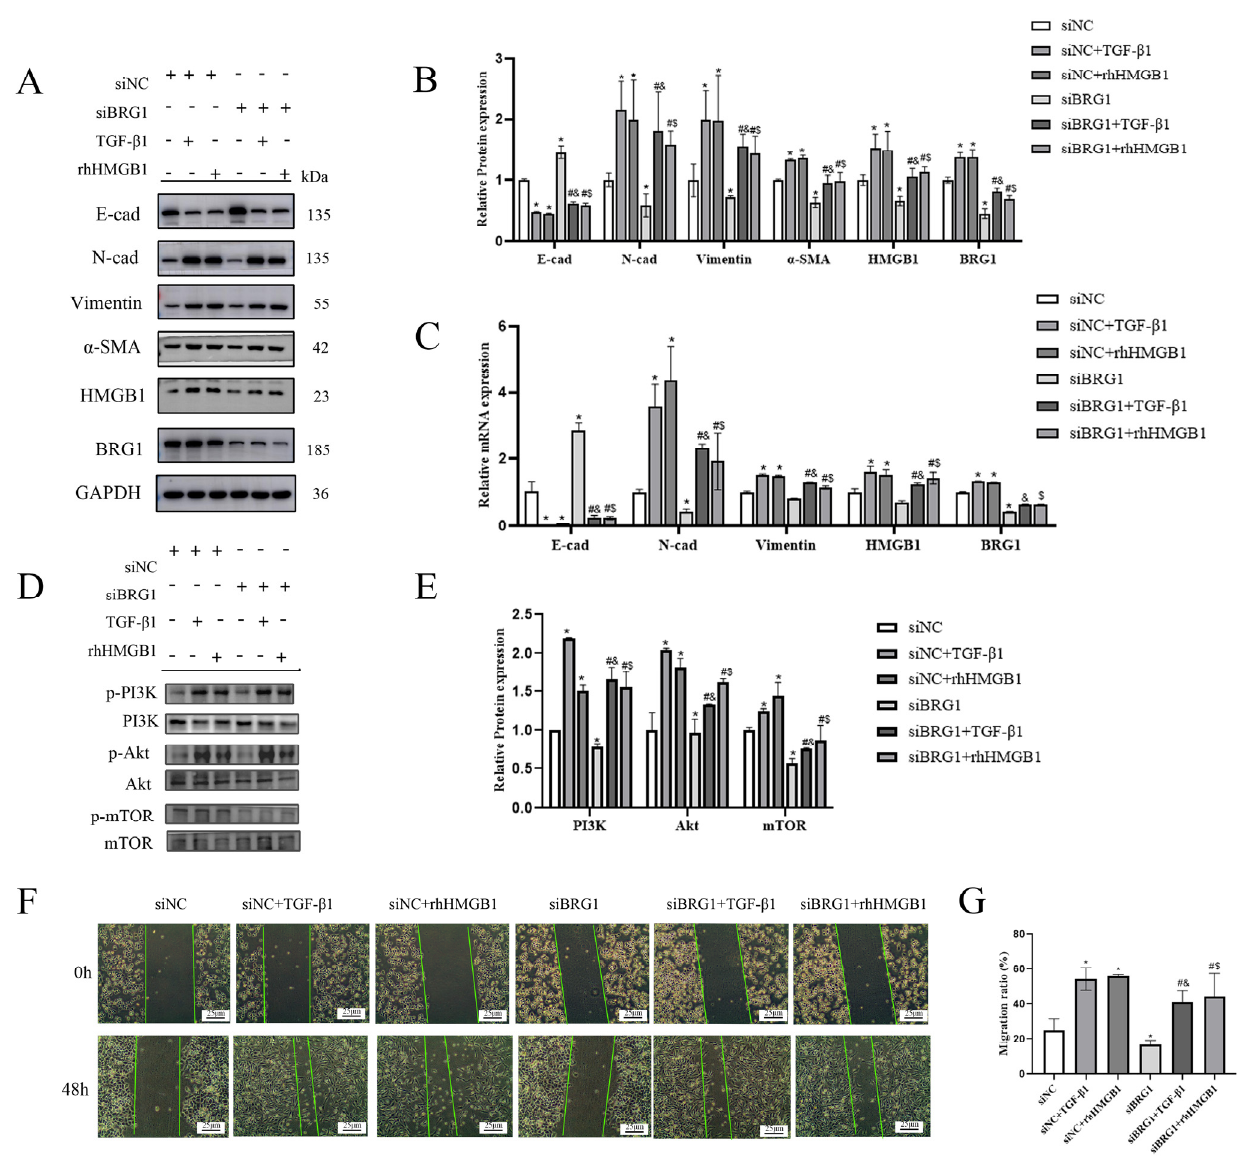
Figure 4. Knocking down BRG1 can slow down the EMT process through PI3K/Akt/mTOR pathway. ( A , C ) After silencing BRG1, cultured in normal medium or medium containing 5 ng/mL TGF- β 1 or 4 ng/mL rhHMGB1 for 48 h. The expression of E-cad, N-cad, Vimentin, α - SMA, HMGB1, BRG1, and GAPDH were detected by Western blotting and RT-qPCR. ( B ) quantification. ( D ) After silencing BRG1, the expression of PI3K, p-PI3K, Akt, p-Akt, mTOR, p-mTOR were detected by Western blotting. ( E ) Quantification. ( F ) A scratch test was carried out after silencing BRG1. ( G ) Quantification. GAPDH was used as an internal control *: p < 0.05 compared with the control group. #: p < 0.05, compared with the siBRG1 group; &: p < 0.05, compared with the siBRG1 + TGF- β 1 group. $: p < 0.05, compared with the siBRG1 + rhHMGB1